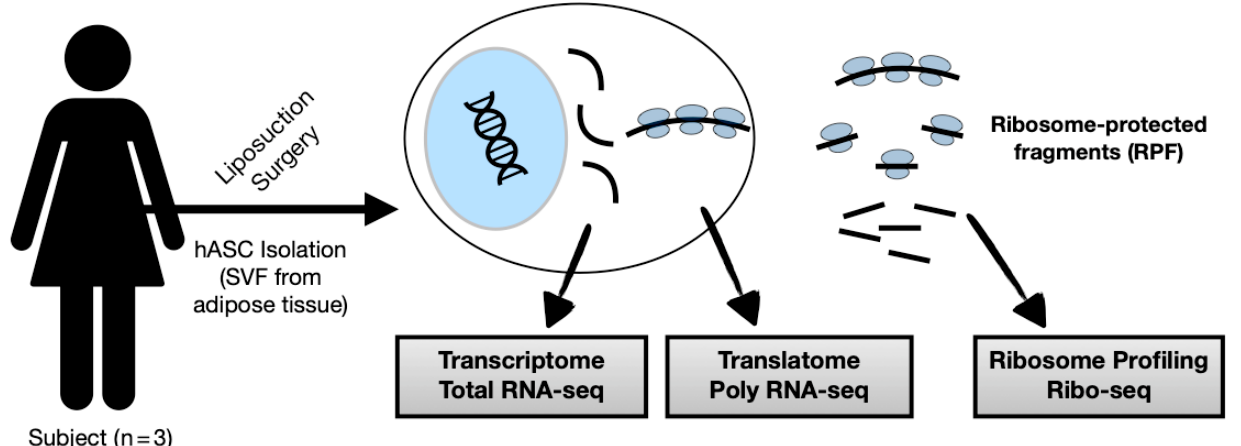
Figure 1. Ribosome profiling was performed in human undifferentiated adipose-derived stem cells (n = 3) followed by massive sequencing (Ribo-seq). For deep analysis, our previous RNA-seq datasets from total fraction (Total RNA-seq) and polysomal fraction (Poly RNA-seq) were collected. Performing bioinformatics analysis, we combined Ribo-seq and RNA-seq datasets to search for the translated smORFs of lncRNAs in hASC. SVF: stromal vascular fraction.